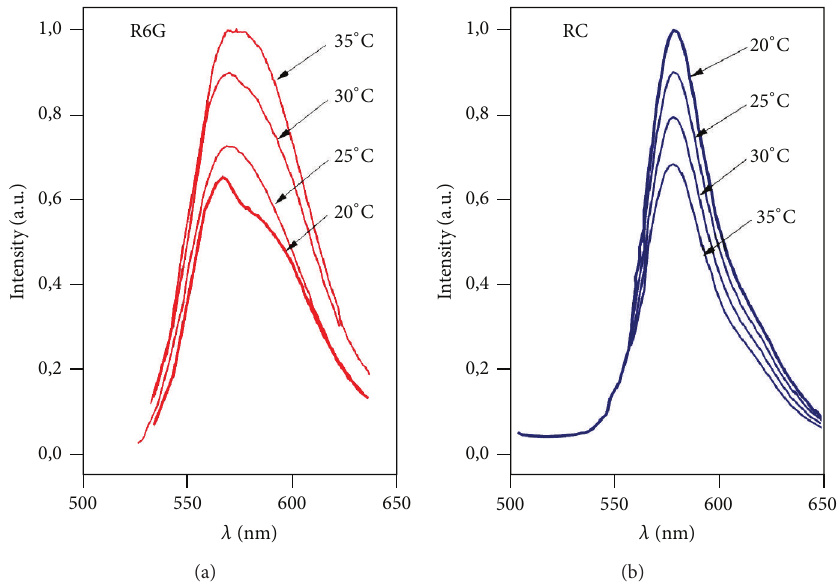
Figure 1: Fluorescence spectrum of Rhodamine 6G (R6G) and Rhodamine C (RC) at 5 ∘ C intervals from 20 to 35 ∘ C.